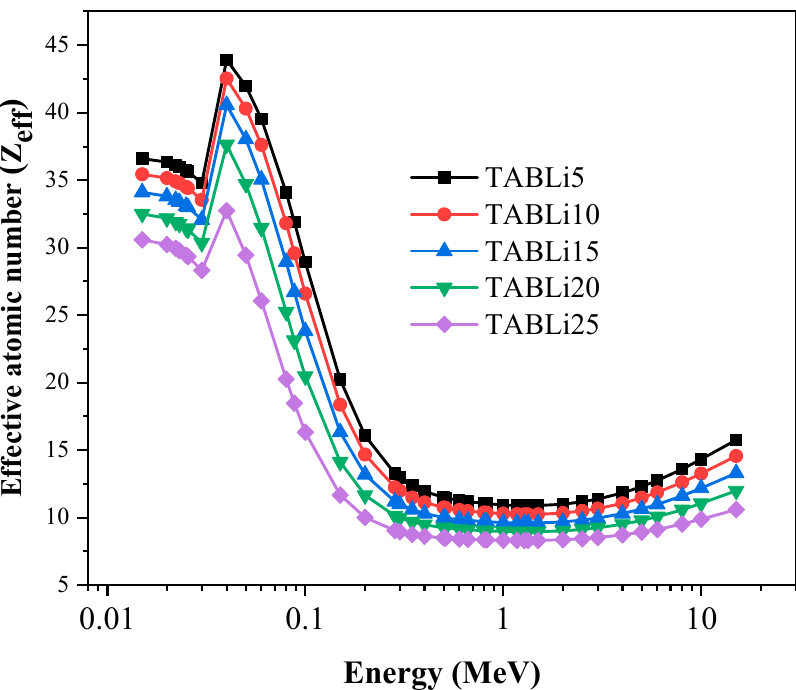
Figure 13. Variation of the studied glasses’ effective atomic number (Z eff ) versus the gamma photon energy.